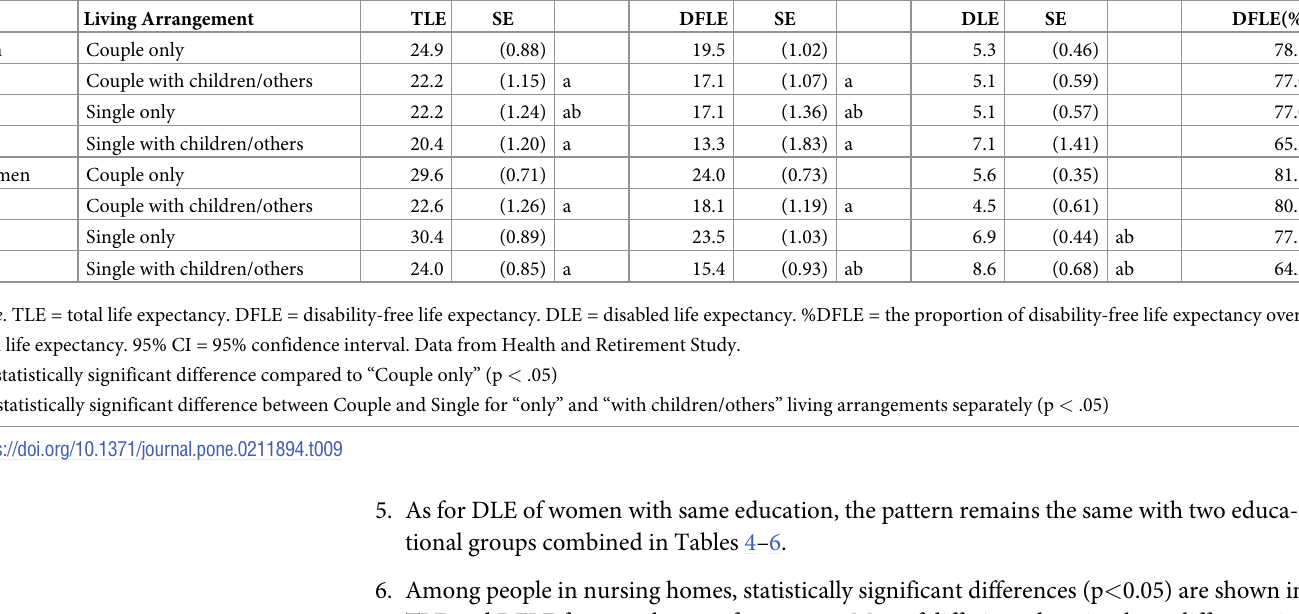
Table 9. Total, disability-free, and disabled life expectancy by gender and living arrangement for non-Hispanic whites at age 50 among those who never change their living arrangement during analysis period: Status-based estimates with initial health state being